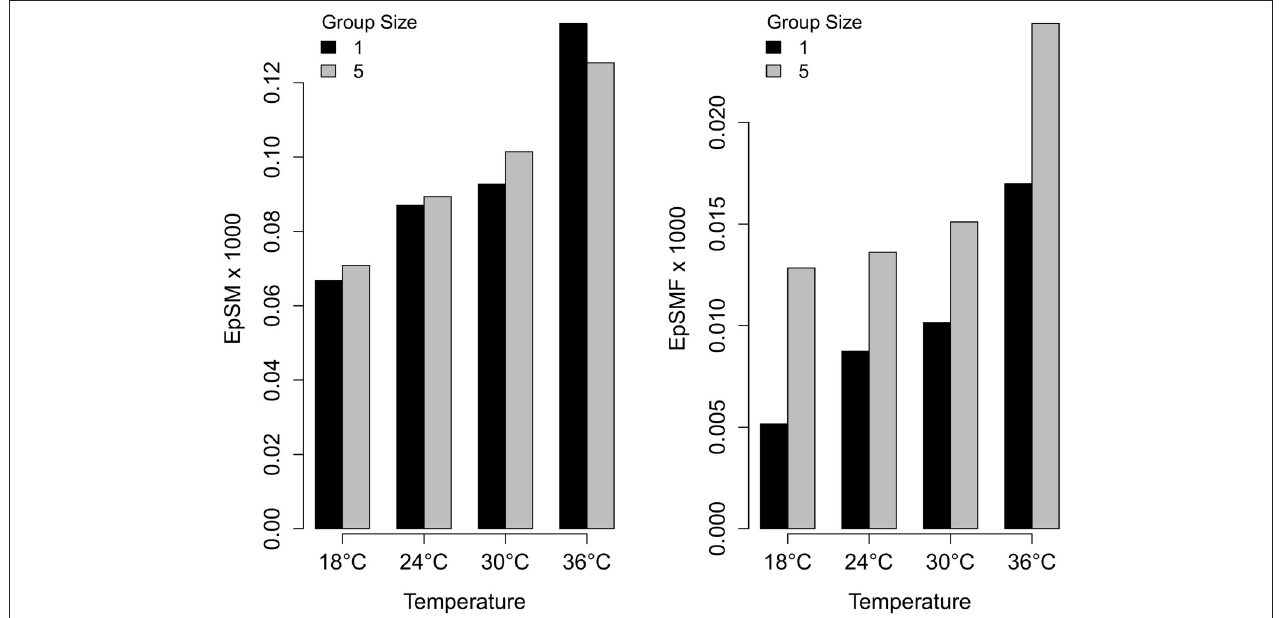
FIGURE 3 | The effect of temperature and group size on feeding efficiency of Stegodyphus dumicola spiders. Left, fly mass extracted per unit spider mass over the duration of the experiment ( EpSM ); right, fly mass extracted per unit spider mass per unit feeding time (10min) ( EpSMF ).